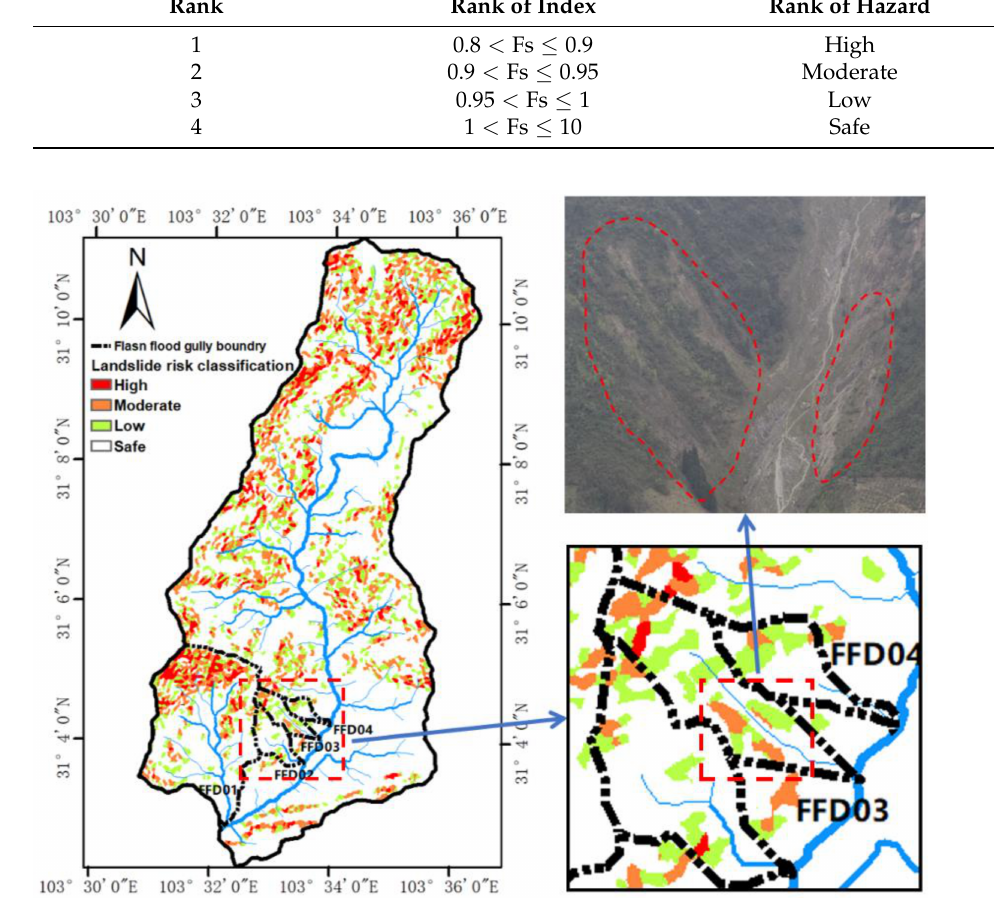
Figure 12. Rainfall data on 13 August